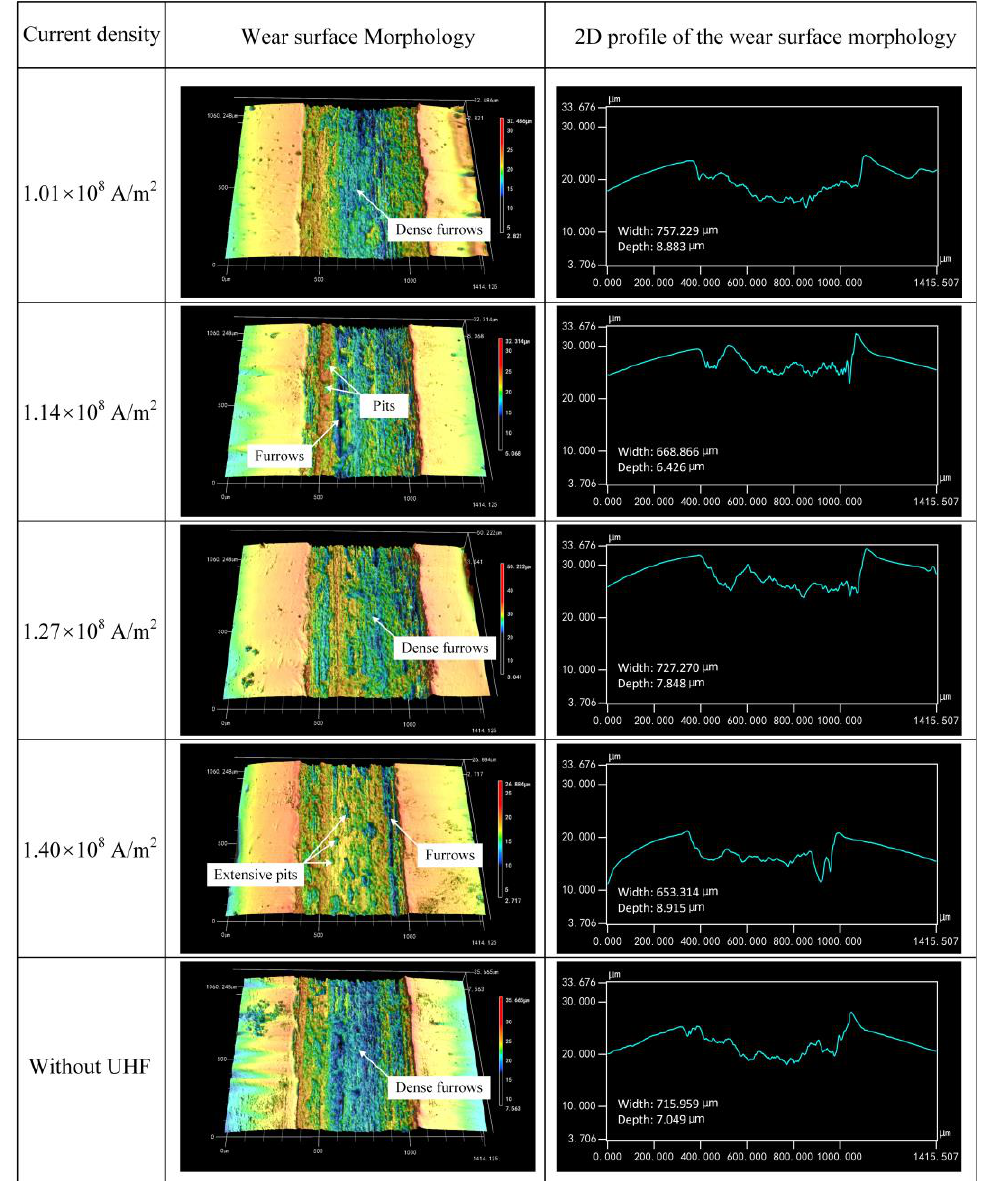
Figure 13. Wear surface morphology ( left ) and 2D profile of the wear surface morphology ( right ) of the laser-UHF induction hybrid deposited layers under different current densities.